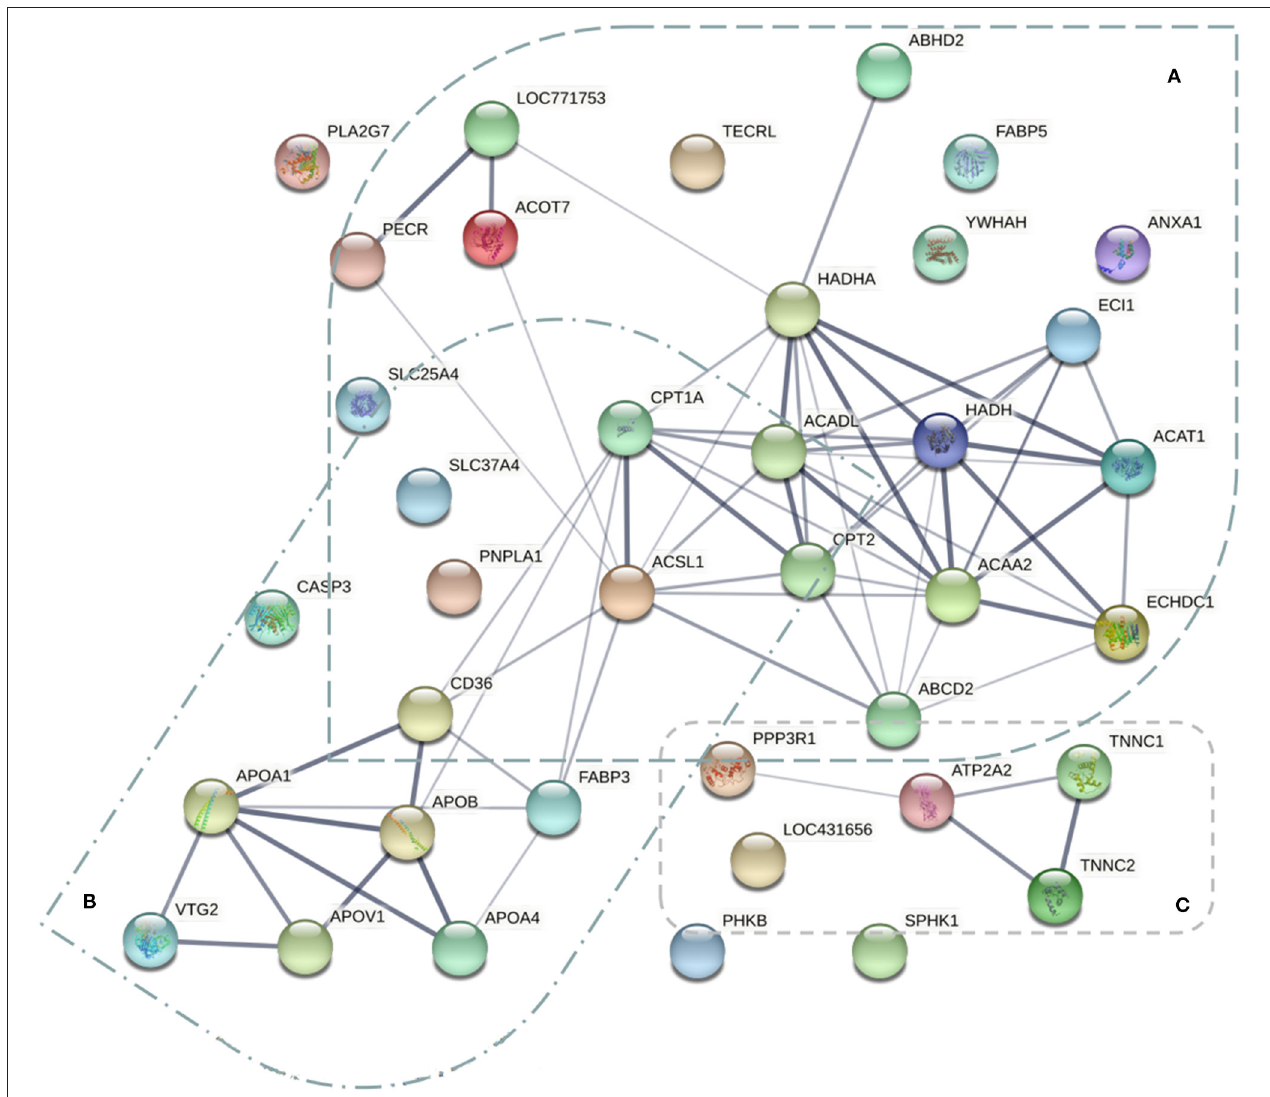
FIGURE 8 | The protein-protein interaction network of the 57 differentially expressed proteins related to fatty acid metabolism of breast muscle. Three functional modules were apparent in the network, forming tightly connected clusters. (A) The proteins related to pathways of fatty acid metabolism. (B) The proteins involved the lipid transport. (C) The proteins associated with calcium signaling